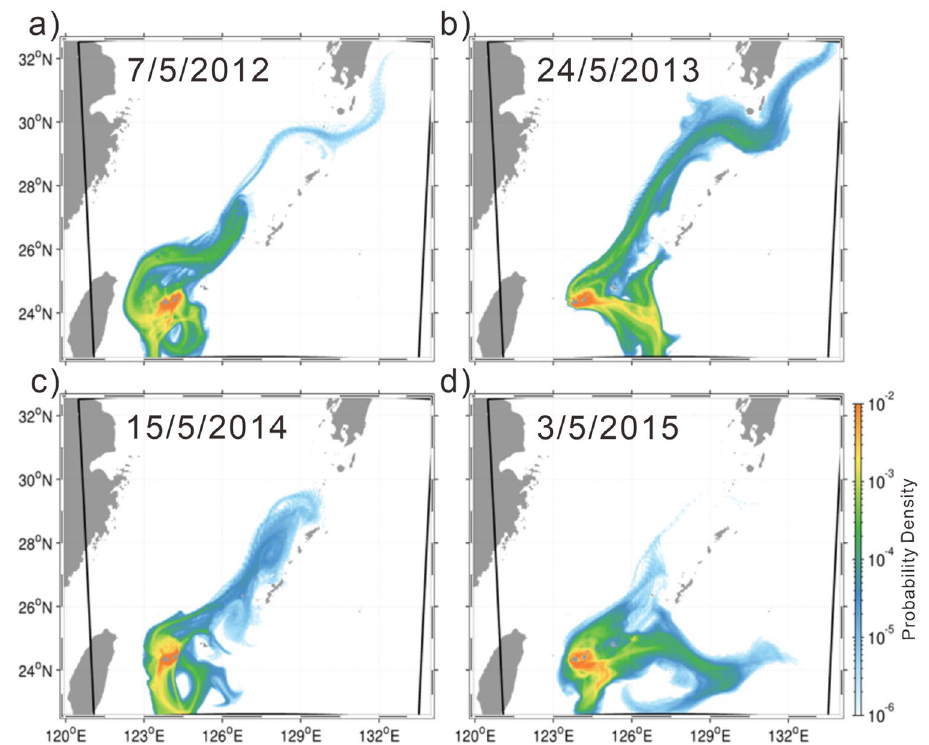
Figure 8. Probability density functions of reachability for particles discharged at 20:00 for 14 days beginning on the night after the full moon during a spring tide in May during the years 2012–2015. Warm colors indicate high probability densities. Advection time was 21 days in all cases, and discharge periods began on (a) 7 May 2012, (b) 24 May 2013, (c) 15 May 2014, and (d) 3 May